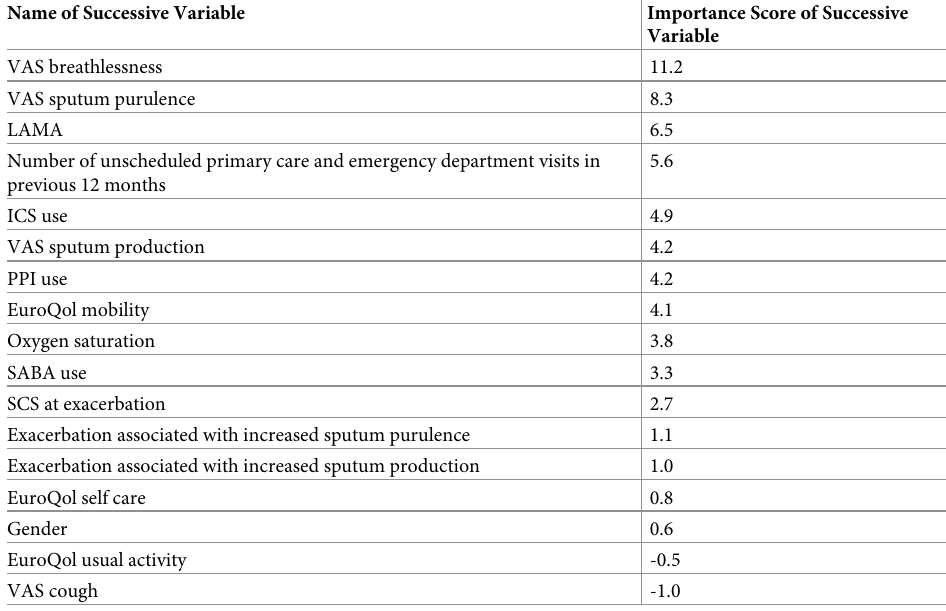
Table 5. Random forest importance scores of variables in multivariate treatment failure prediction models for all